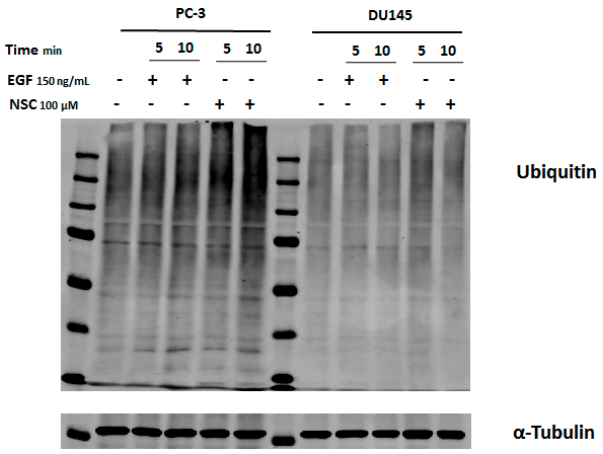
Figure 4. Assessment of protein ubiquitination in cancer cells exposed to EGF and NSC. Serum-starved PC-3 and DU145 cells were exposed to NSC (100 µM), or to EGF (150 ng/mL) for 5 or 10 min. Cell lysates were analyzed with anti-ubiquitin antibody recognizing ubiquitinated sites in proteins.